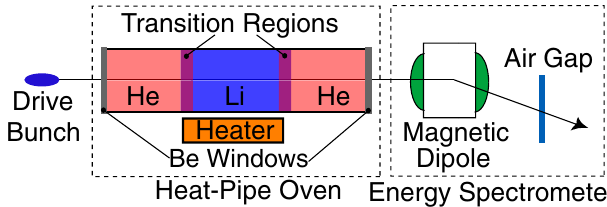
FIG. 3. (Color) The experimental layout of the heat-pipe oven and the energy